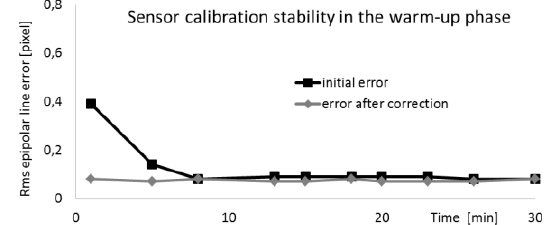
Figure 6: Rms epipolar line error of scanner DS 1 over two hours from switch on, 2011/02/07, measuring object: plane